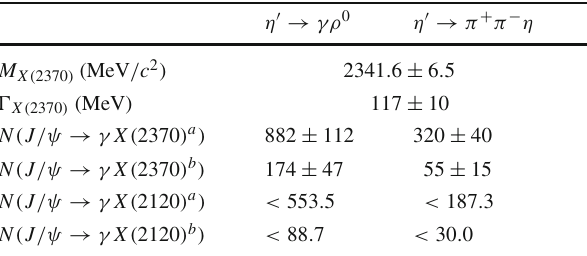
Table 1 Fit results for the structure around 2 . 34GeV / c 2 and 2 . 12GeV / c 2 . The superscripts a and b represent the decay modes